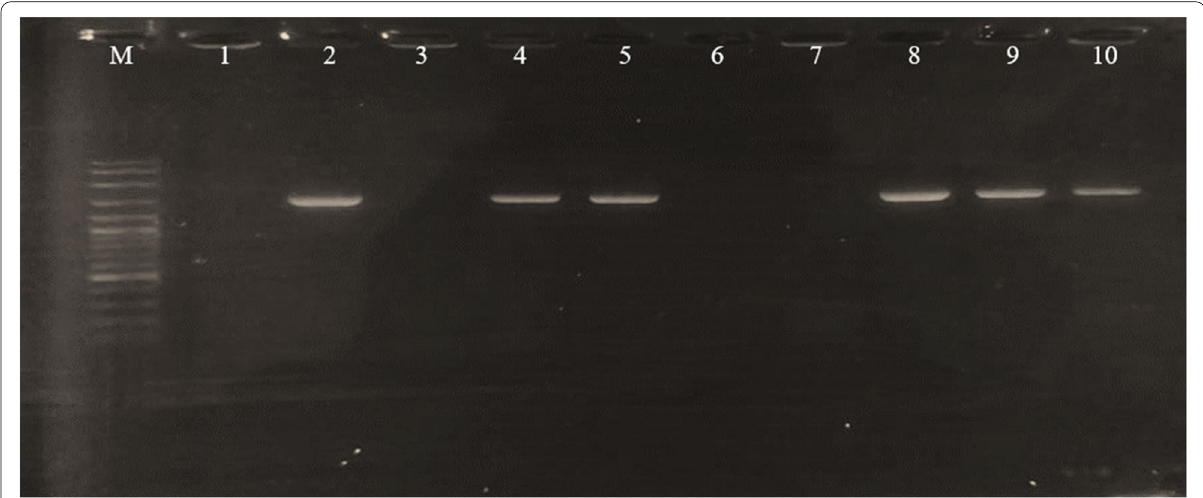
Fig. 4 Electrophoregram of PCR colonies results to confirm the presence of pETSUMOL1HPV52 inside E. coli BL21 DE3 expression host . M: 100 bp DNA ladder (Vivantis); code number 1–10 represents transformant colonies number. As seen on the picture, 6 samples out of 10 confirmed of having the L1HPV52